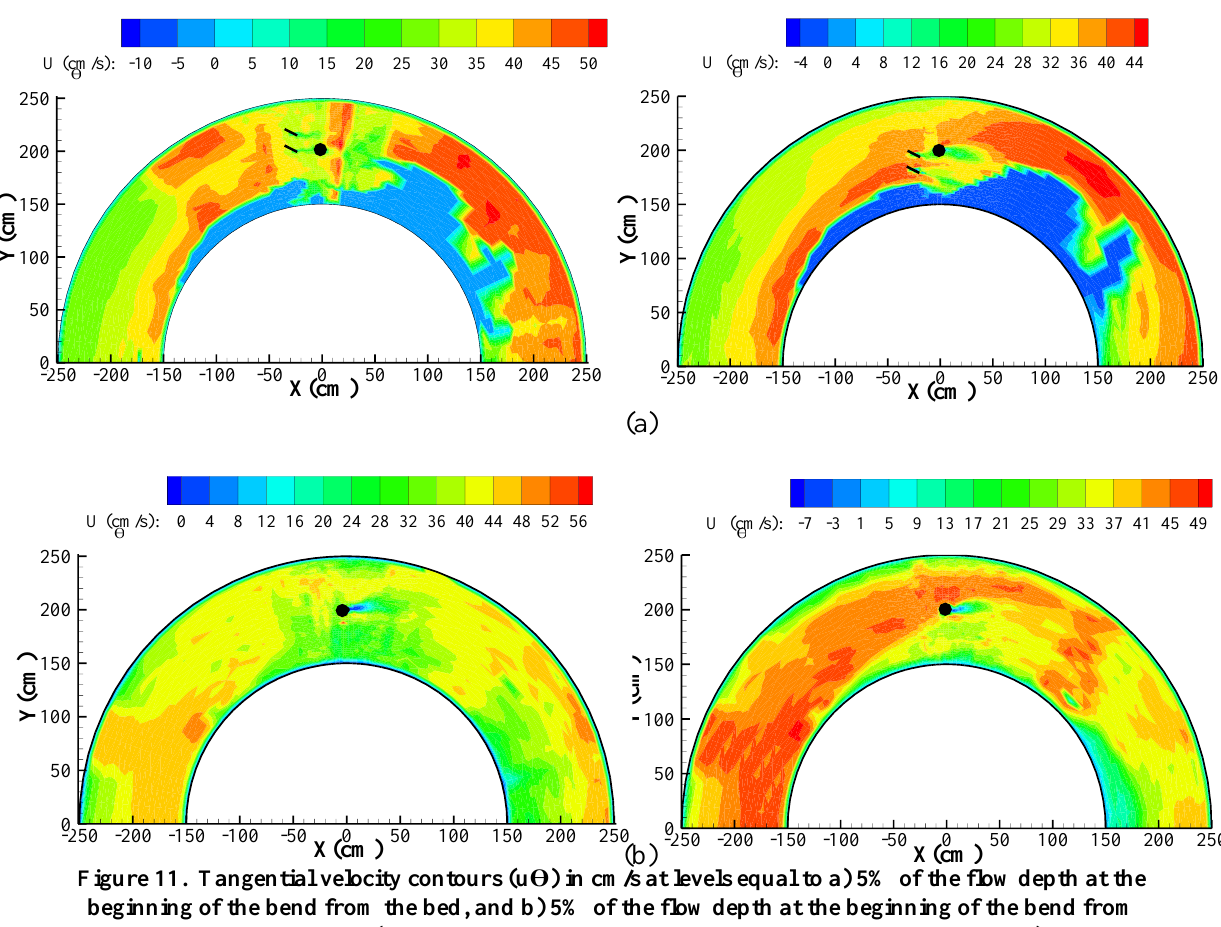
Figure 11. Tangential velocity contours (uϴ) in cm/s at levels equal to a) 5% of the flow depth at the beginning of the bend from the bed, and b) 5% of the flow depth at the beginning of the bend from the water surface (PFV experiment on the right, and PSV experiment on the left) The radial velocity contour at plan sections at levels of 5 and 95% of the flow depth at the beginning of the bend from the bed is presented in Figure (12). According to Figure (12), at the plan sections, the negative values of the radial velocity (towards the inner bank) can be